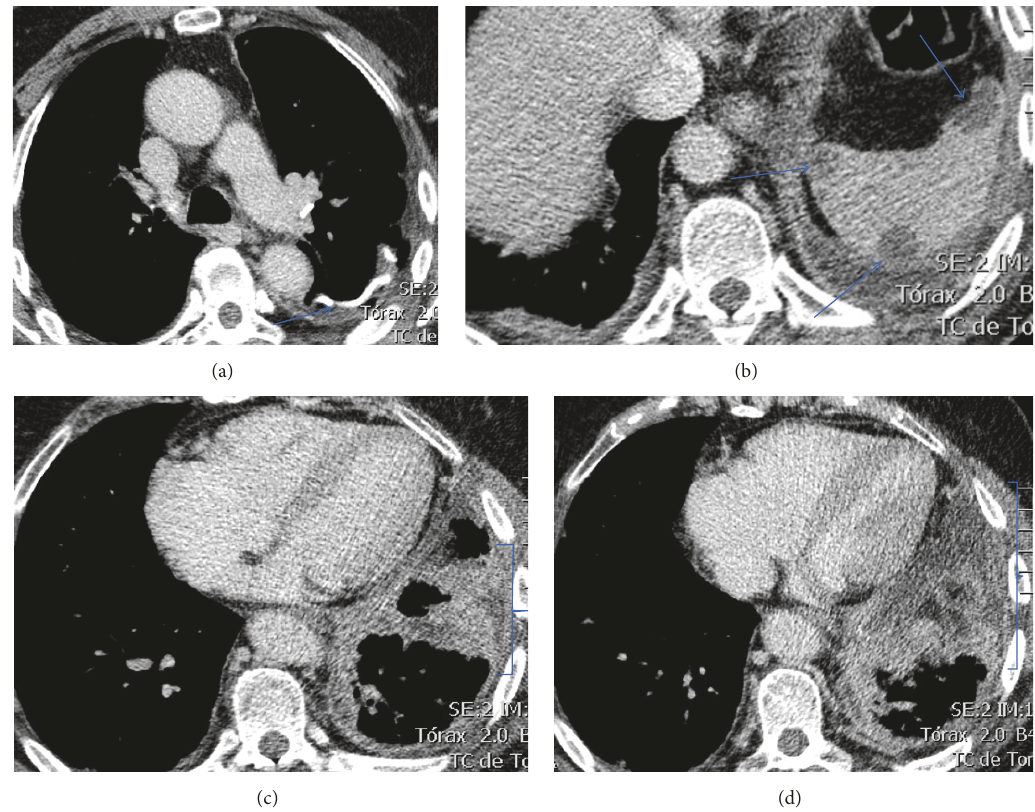
Figure 11: Chest CT. Multislice chest axial CT-images on mediastinal window show (a) signs of previous atypical wedge resection in the left lower lobe (arrow); (b) more nodular lesions in the spleen (arrows); (c and d) more pronounced and diffuse pleural invasion